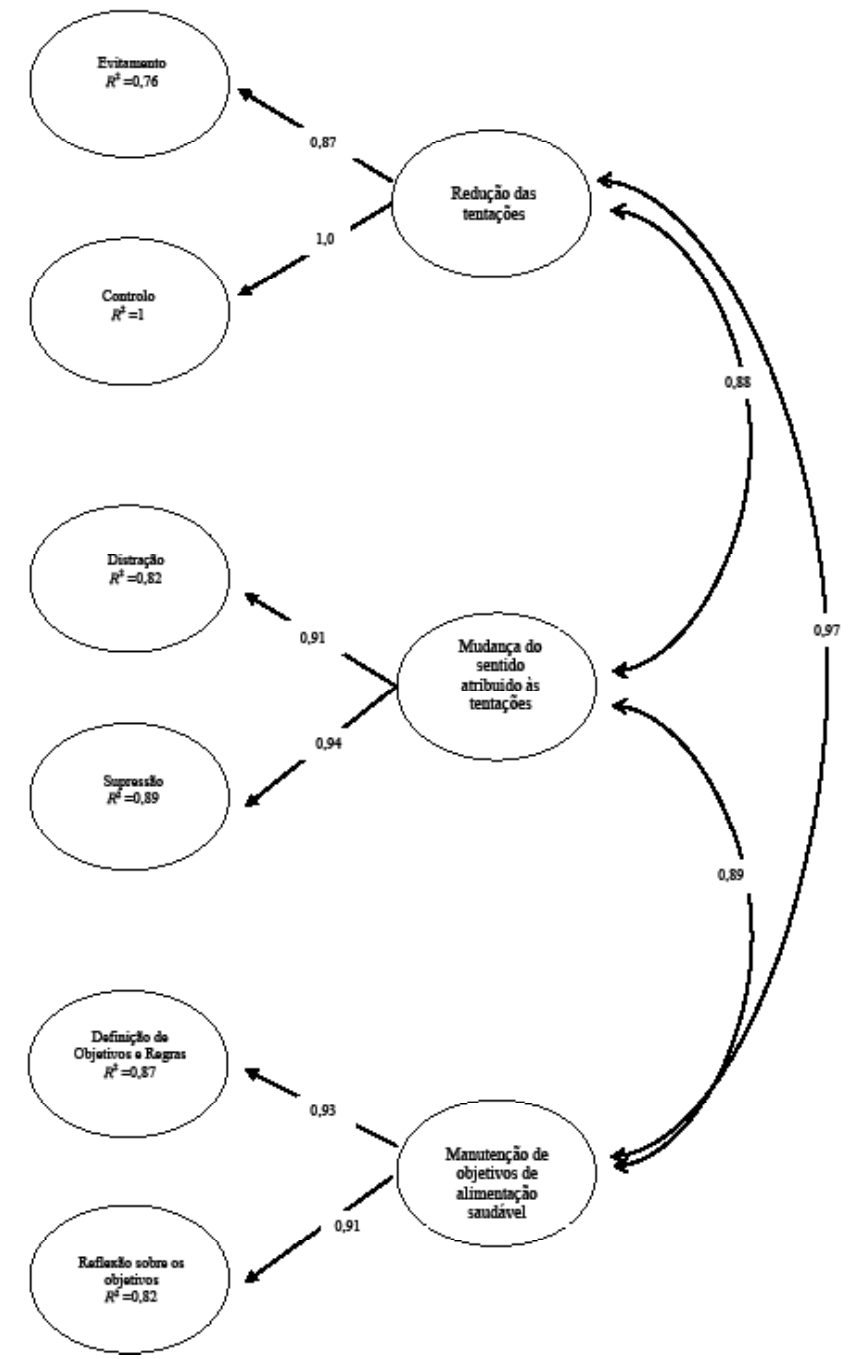
Figura 2 . Análise fatorial con fi rmatória